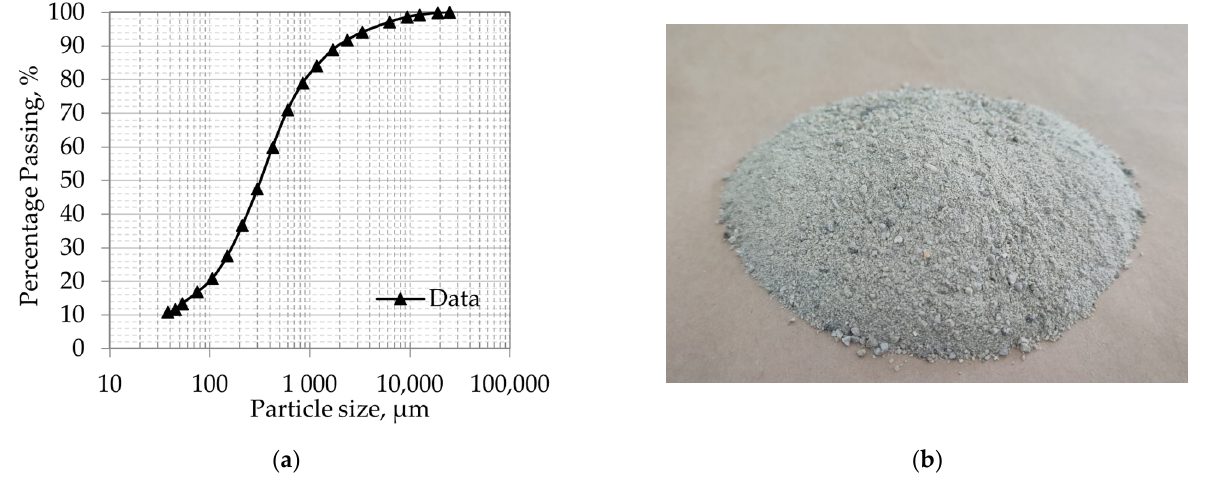
Figure A1. ( a ) Particle size distribution in the underflow of the hydrocyclones, ( b ) a sample from the hydrocyclones